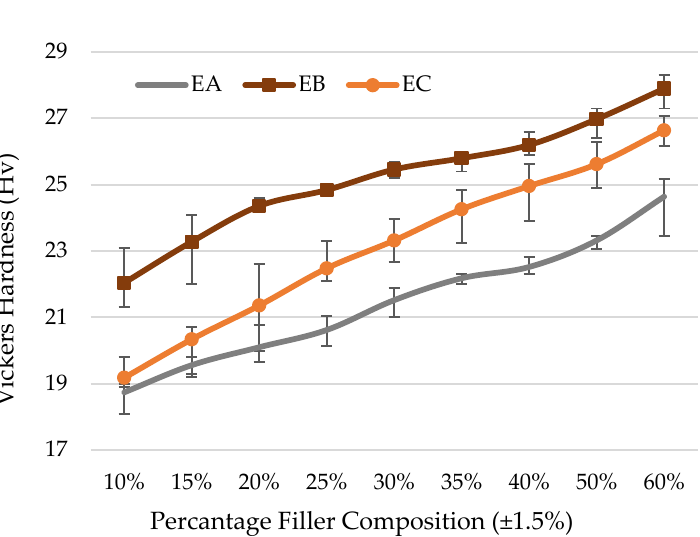
Table 8. Summary of Compressive strength values for EA, EB, and EC.